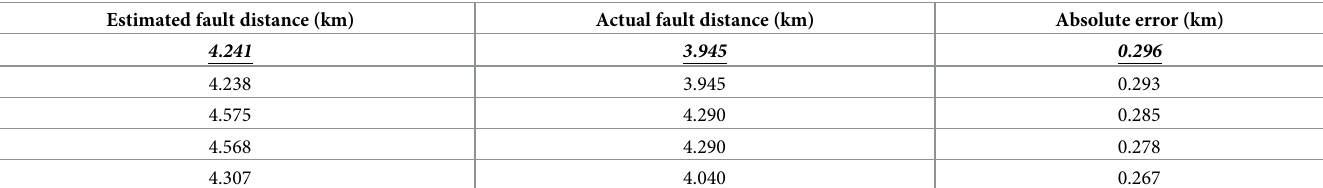
Table 9. Fault distance estimation